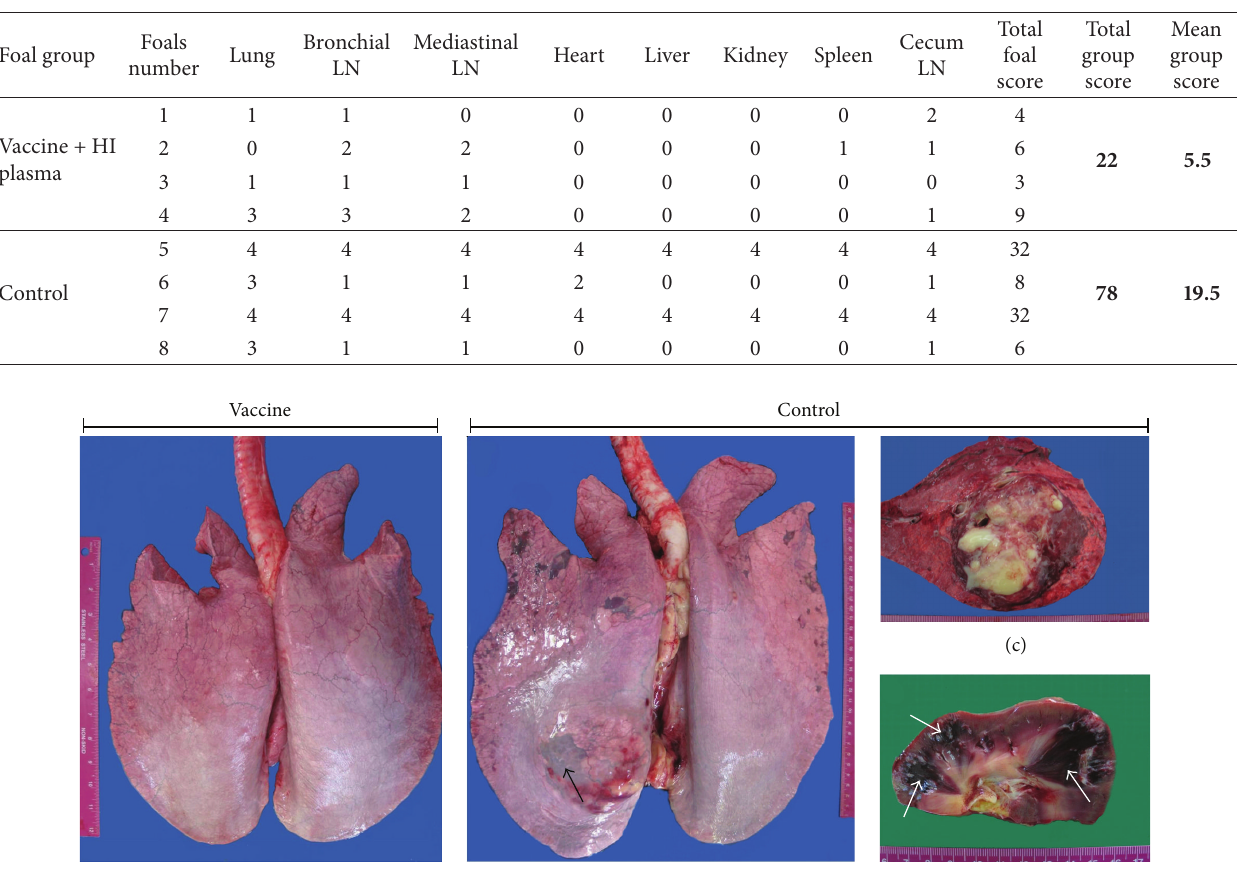
the IFN- 𝛾 and IL-4 concentration measured 4.1-fold and